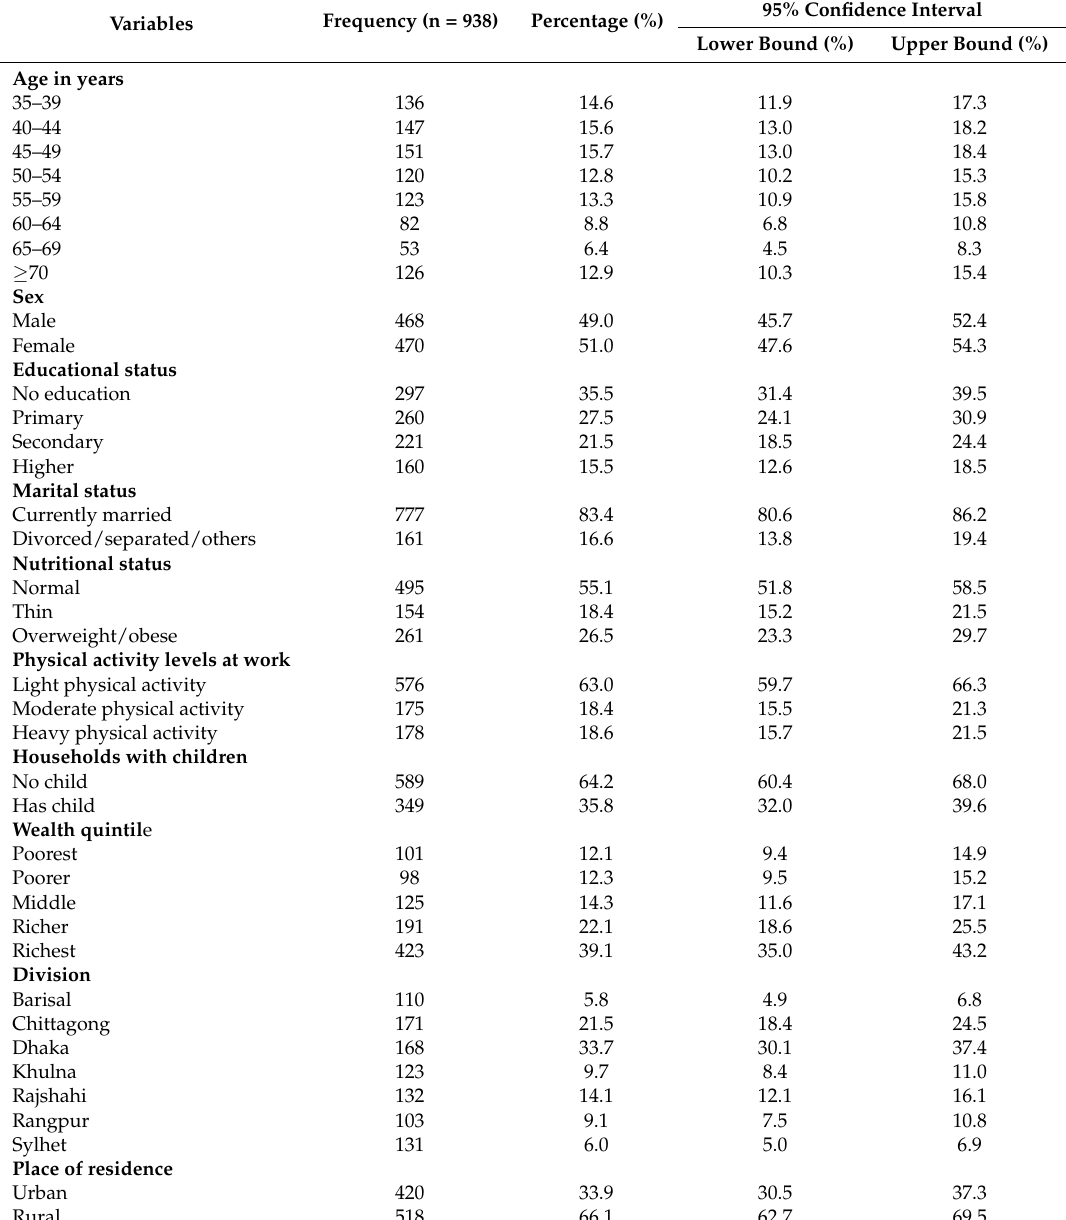
Table 1. Characteristics of the study